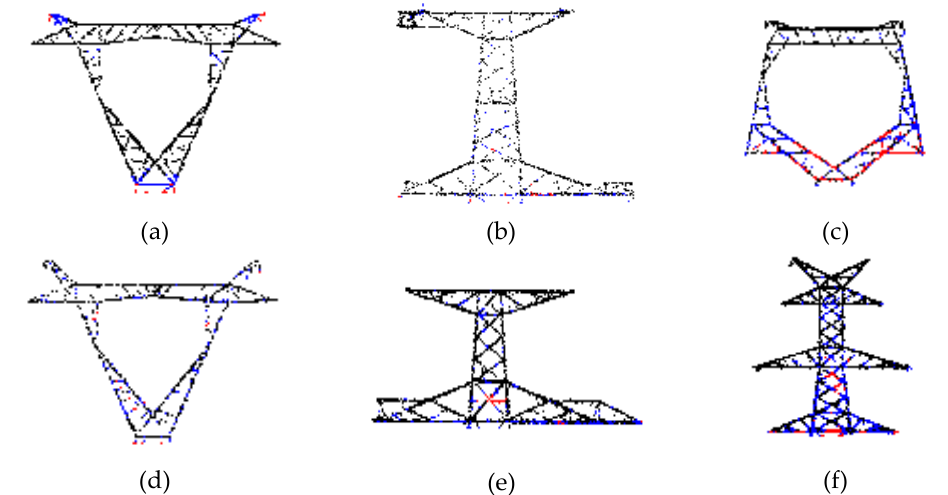
Figure 13. Visualization of tilt deformation using chromatic aberration for different types of tower body (a)-(f) represents six typical types of tower body.